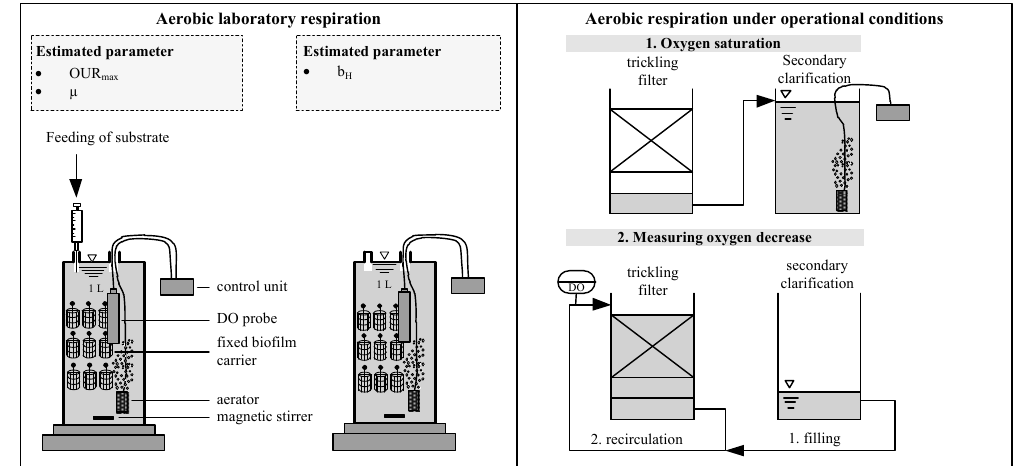
Figure 6. Schema of the respirometry measurement of the oxygen uptake rate.